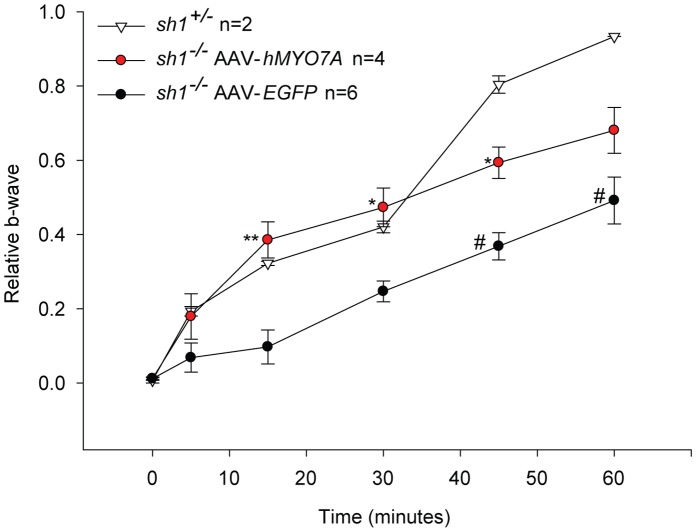
Subretinal delivery of AAV encoding human Myo7a improves recovery from light desensitization in adult sh1−/− mice.The graph shows the recovery from light desensitization in albino sh1−/− mice 6 months following AAV injection. The relative b-wave is the ratio between the post- and the pre-desensitization b-wave amplitudes (µV) both evoked by 1 cd*s/m2. The time (minutes) refers to the time post-desensitization. To assess statistical significance Two-way ANOVA was used: the statistical significant differences between sh1+/− and sh1−/− mice from the post-hoc Multiple Comparison Procedure are depicted: *p value<0.05; ** and # p<0.001. Asterisks label significant differences between hMYOA- and EGFP-treated eyes; pound keys label significant differences between EGFP-treated eyes and sh1+/− eyes. More details on the statistical analysis can be found in the Statistical analysis paragraph of the Materials and Methods section. AAV-hMYO7A: AAV2/5-CMV-hMYO7A; AAV-EGFP: AAV2/5-CMV-EGFP.